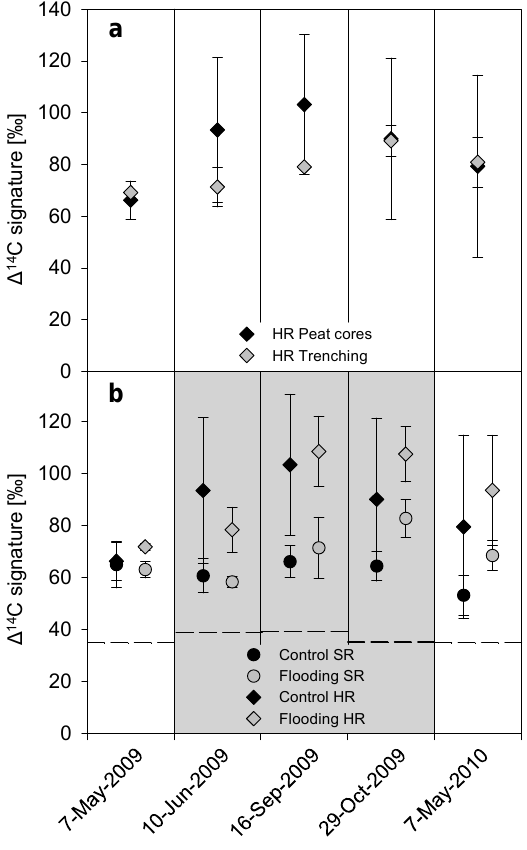
Fig. 4. ( a ) Mean Δ 14 C signatures of heterotrophic respiration (HR) determined by laboratory incubation of peat cores from control plots (black diamonds) and by field incubation in the trenched subplots (grey diamonds). ( b ) Mean Δ 14 C signatures of soil CO 2 efflux (SR, circles) and heterotrophic respiration (HR, diamonds) in control (black) and flooded plots (grey). Dashed lines represent the mean Δ 14 C signatures of rhizosphere respiration (RR). Sampling dates within the period of experimental flooding are shaded. Error bars represent the standard deviation of the mean (SD).